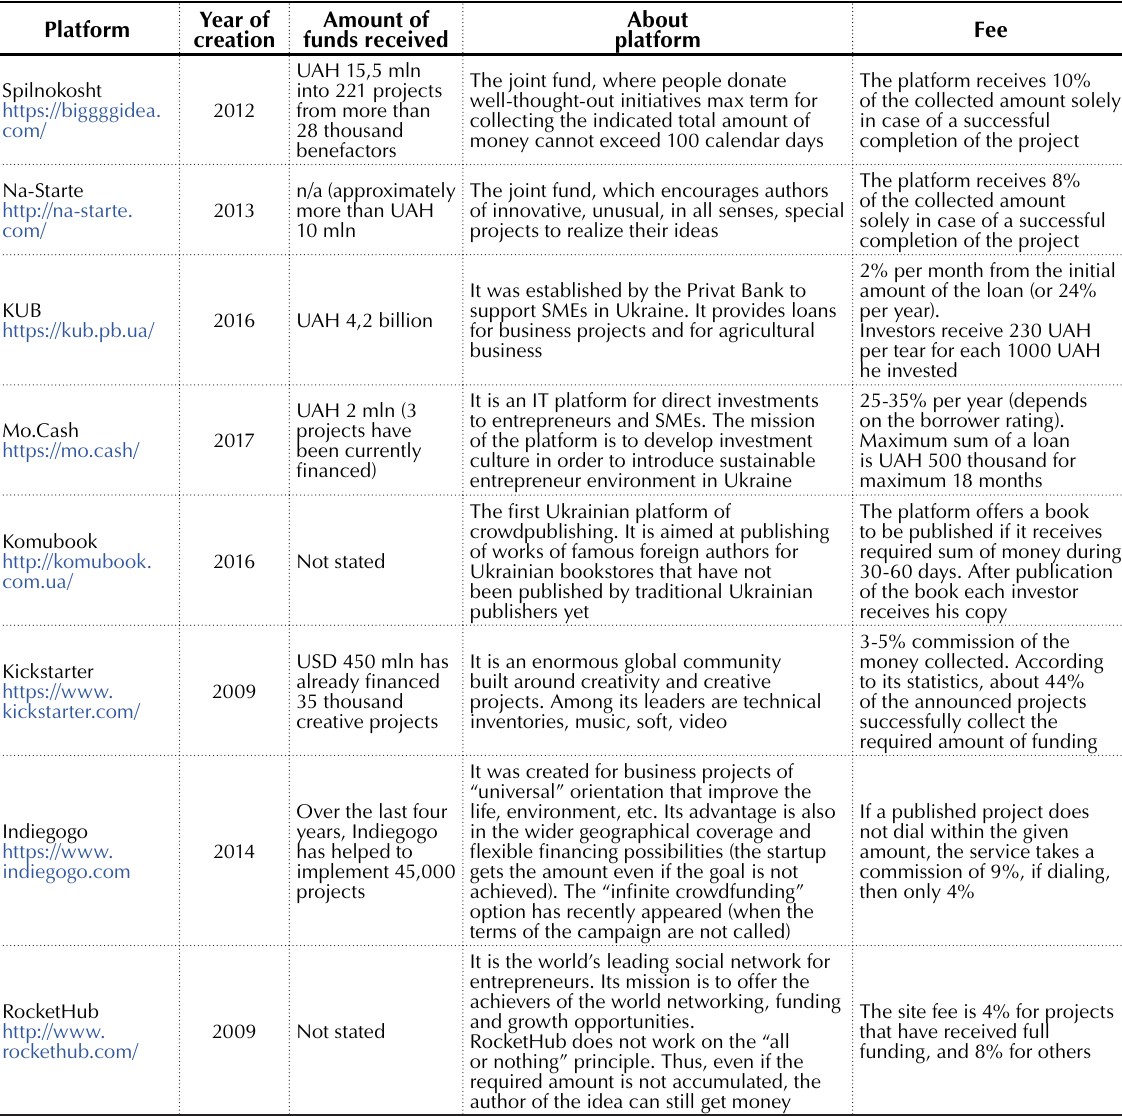
Table 1. Types of crowdfunding platforms for SMEs